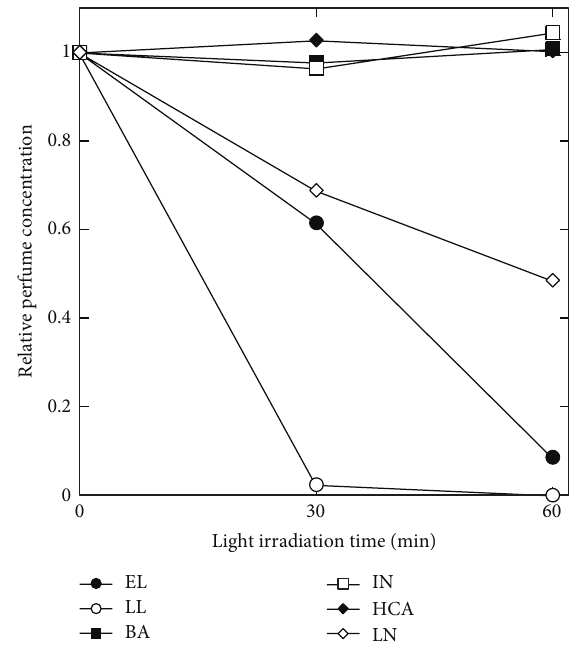
Figure 6: Diameter of oil droplets in O/W emulsion before and after 60-minute light irradiation.